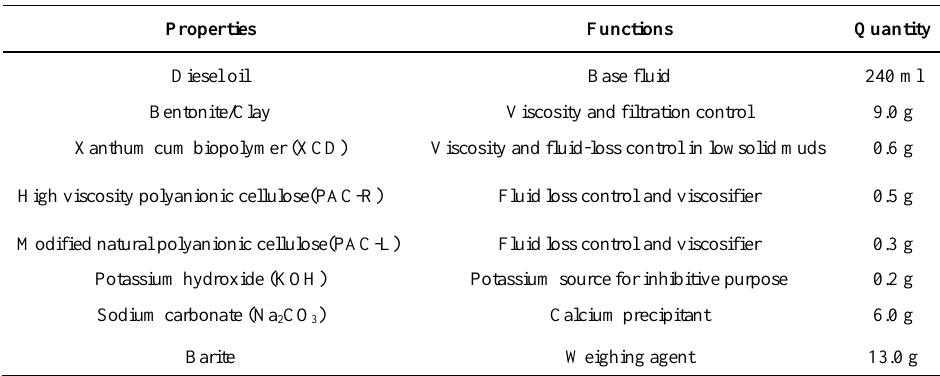
Table 1. The raw materials used for the formulation of OBMB and